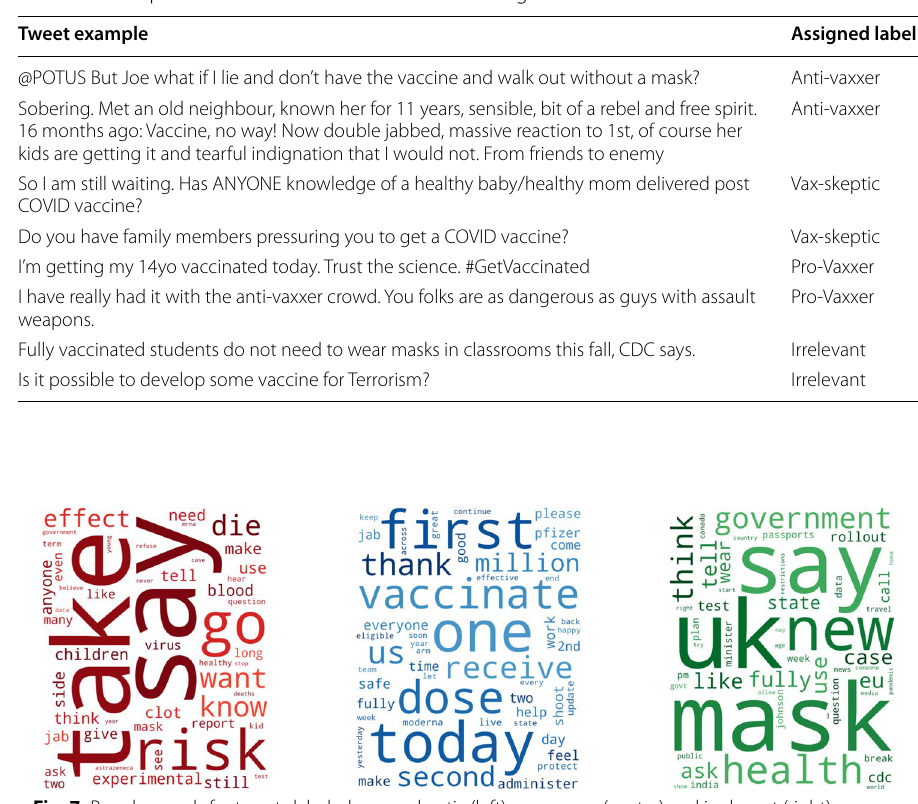
Fig. 7 Popular words for tweets labeled as vax-skeptic (left), pro-vaxxer (center) and irrelevant